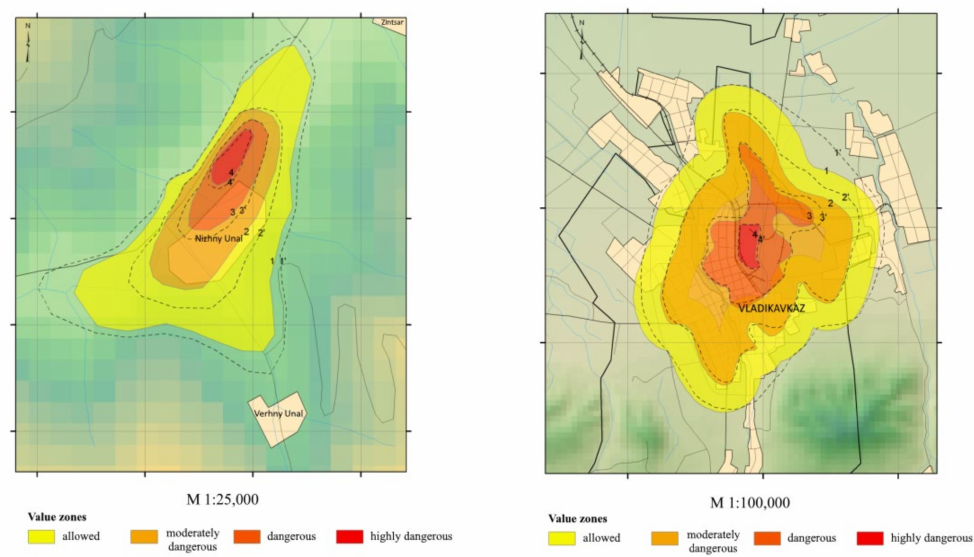
Figure 3. Maps of soil pollution dynamics over